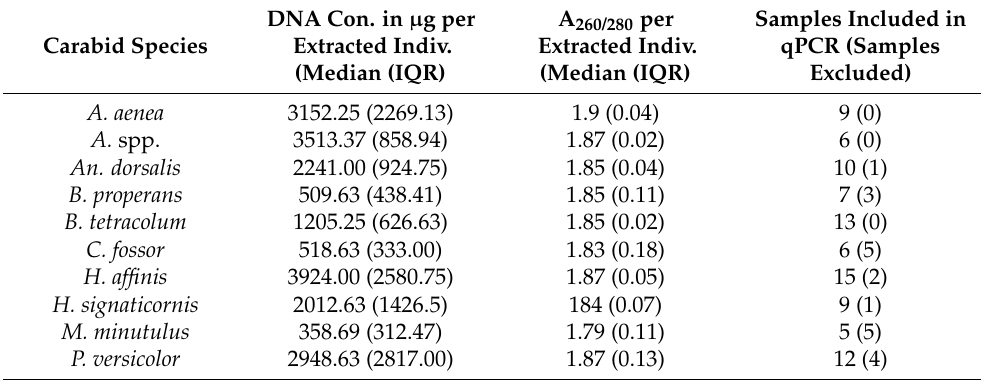
Table 3. Median and interquartile range (IQR) of the DNA concentration (con.) in µ g, the DNA quality (A 260/280 ) per extracted individual (indiv.) of carabid species, and the number of samples included and excluded for a qPCR analysis in the molecular biological approach. Only samples with an A 260/280 between 1.6 and 2.1 were included in the